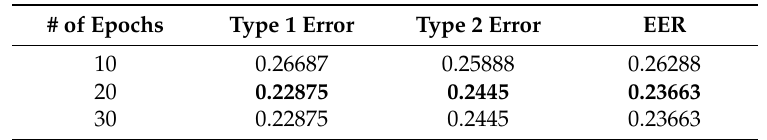
Table 5. Testing results from the proposed CNN classification system for open/closed eyes based on a changing number of training epochs (unit: %).